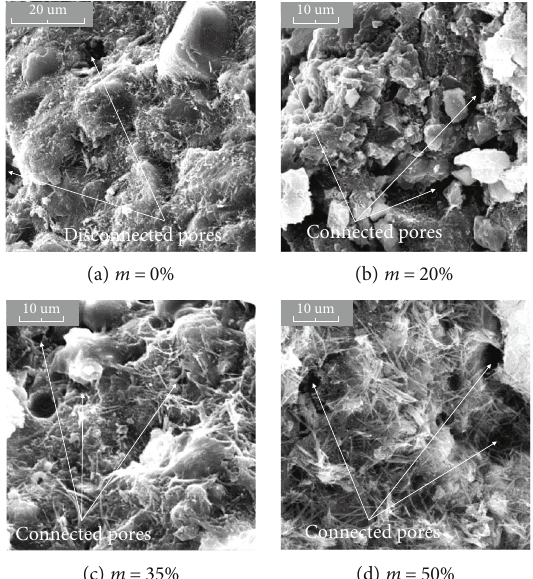
Figure 6: Pore characteristics of concrete mixed with fl y ash ( n = 120